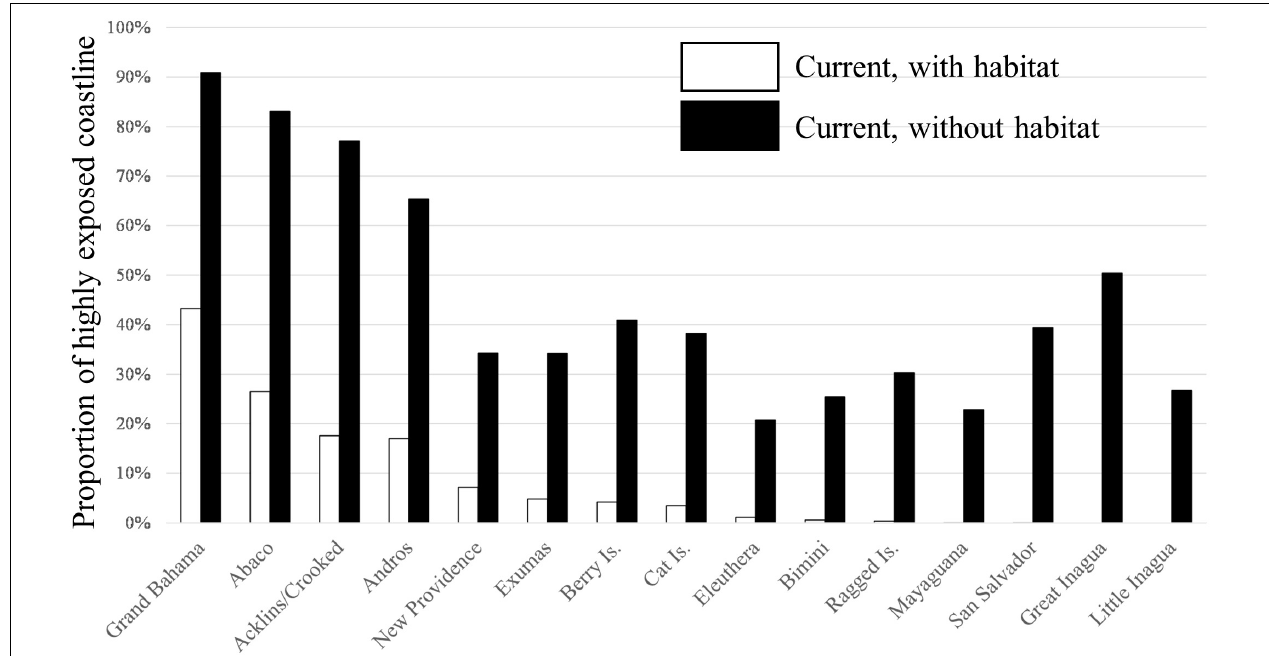
FIGURE 4 | Percentage of highly exposed coastline for each major island in The Bahamas, with and without coastal and marine ecosystems. This is for the current scenario, not accounting for SLR.